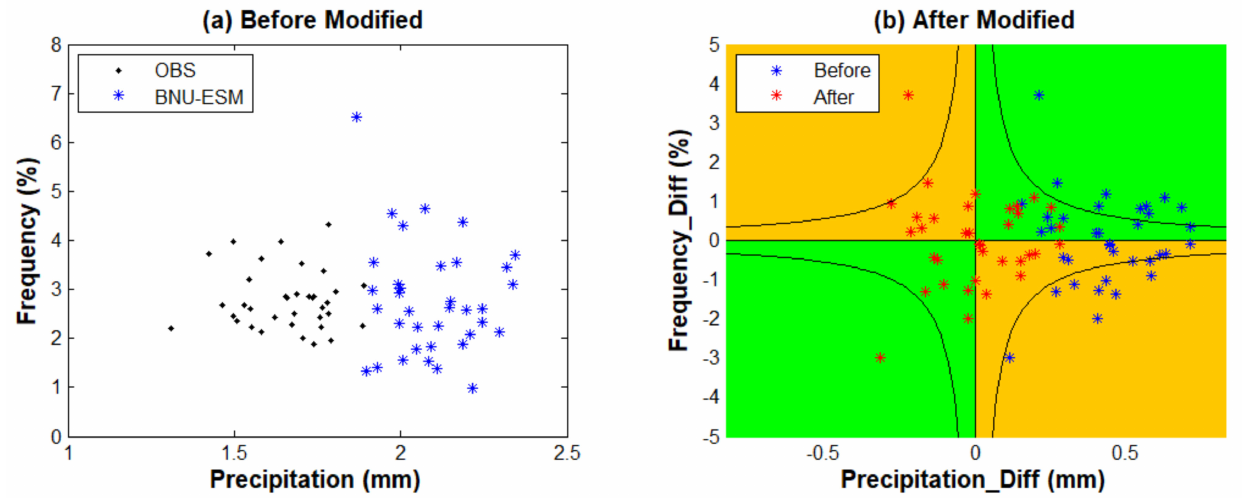
Figure 7. The distribution of the BNU-ESM model deviation before and after modification in summer: ( a ) precipitation and frequency distribution of 36 types before difference revision; ( b ) distribution of precipitation difference and frequency difference in the BNU-ESM model data before and after difference revision. The horizontal axis is the precipitation difference and the vertical axis is the frequency difference. Blue stars represent before difference revision, and red stars represent after difference revision. Different background colors are used to distinguish dry or wet. The green quadrant indicates wet differences and the orange quadrant dry differences. The inside of the curve indicates a position closer to the origin of the coordinates and less difference. The different colors for the stars are used to distinguish before and after difference